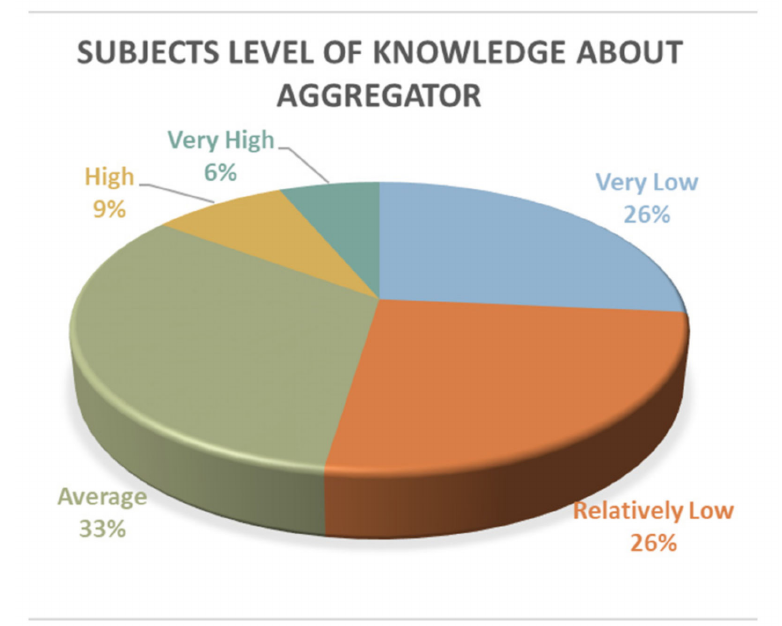
Figure 8. Consumers level of knowledge about the aggregator. Source: Authors’ own research.